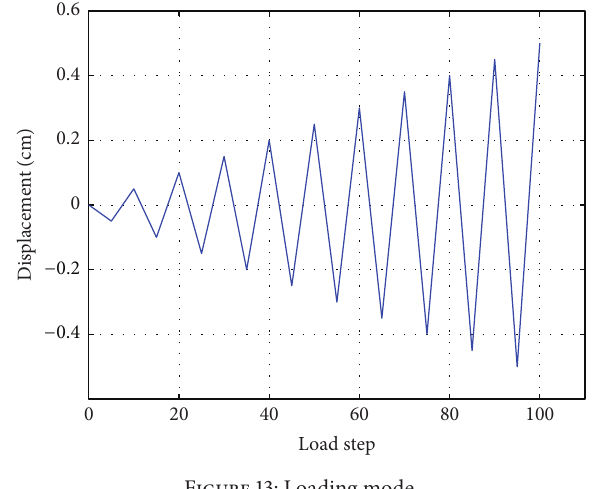
Figure 13: Loading mode.